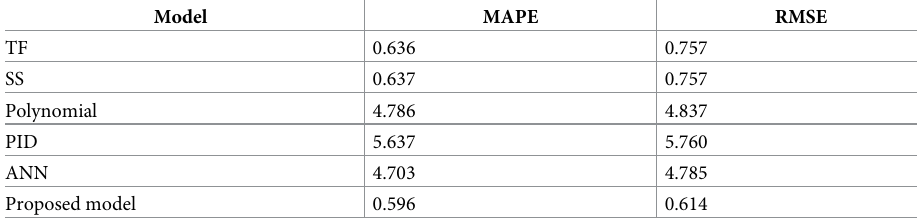
Table 5. Comparison between different thermal